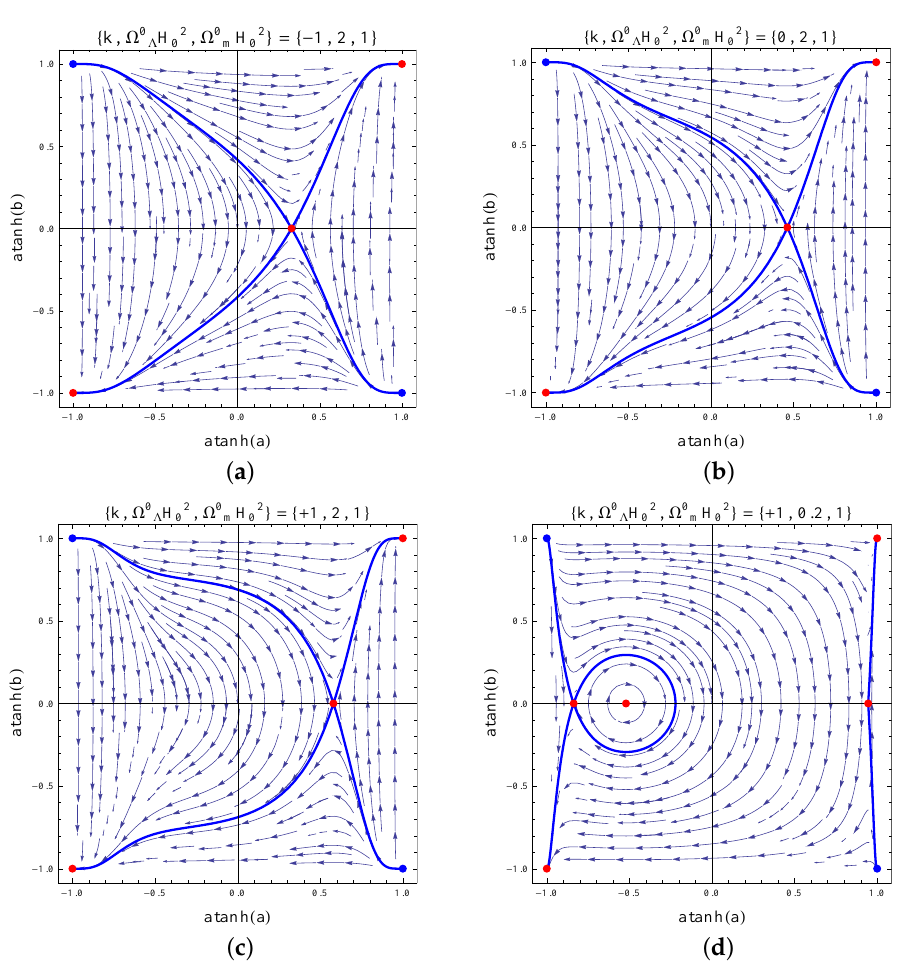
Figure 1. Phase-diagrams displaying the behaviour of the vector field ( a , a (cid:48) ) for GR with a negative G . From left to right and from top to down: ( a ) represents the k = − 1 models, ( b ) the k = 0 models, and ( c , d ) correspond both to the k = + 1